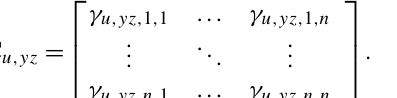
series of wind speed fluctuations are generated by applying inverse fast Fourier transform (IFFT) (Heideman et al., 1985) to the